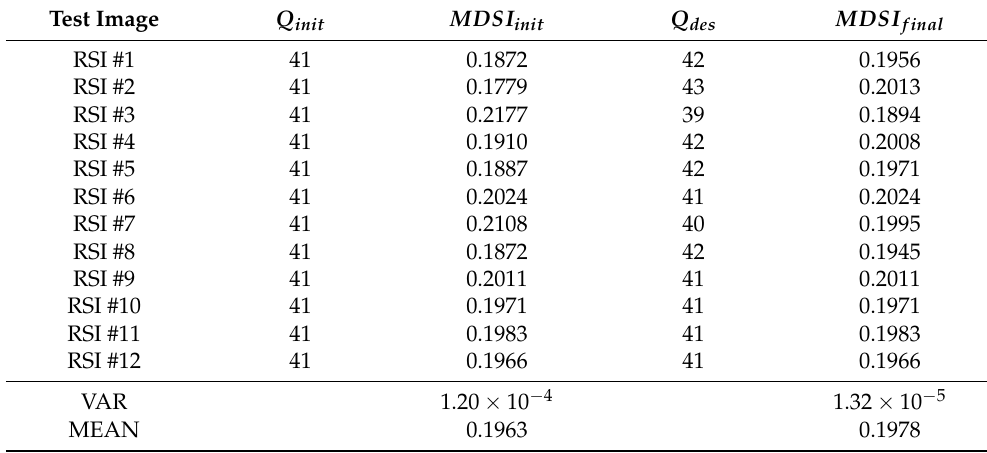
Table A5. The experimental data obtained for the basic image set for the desired MDSI = 0.2.